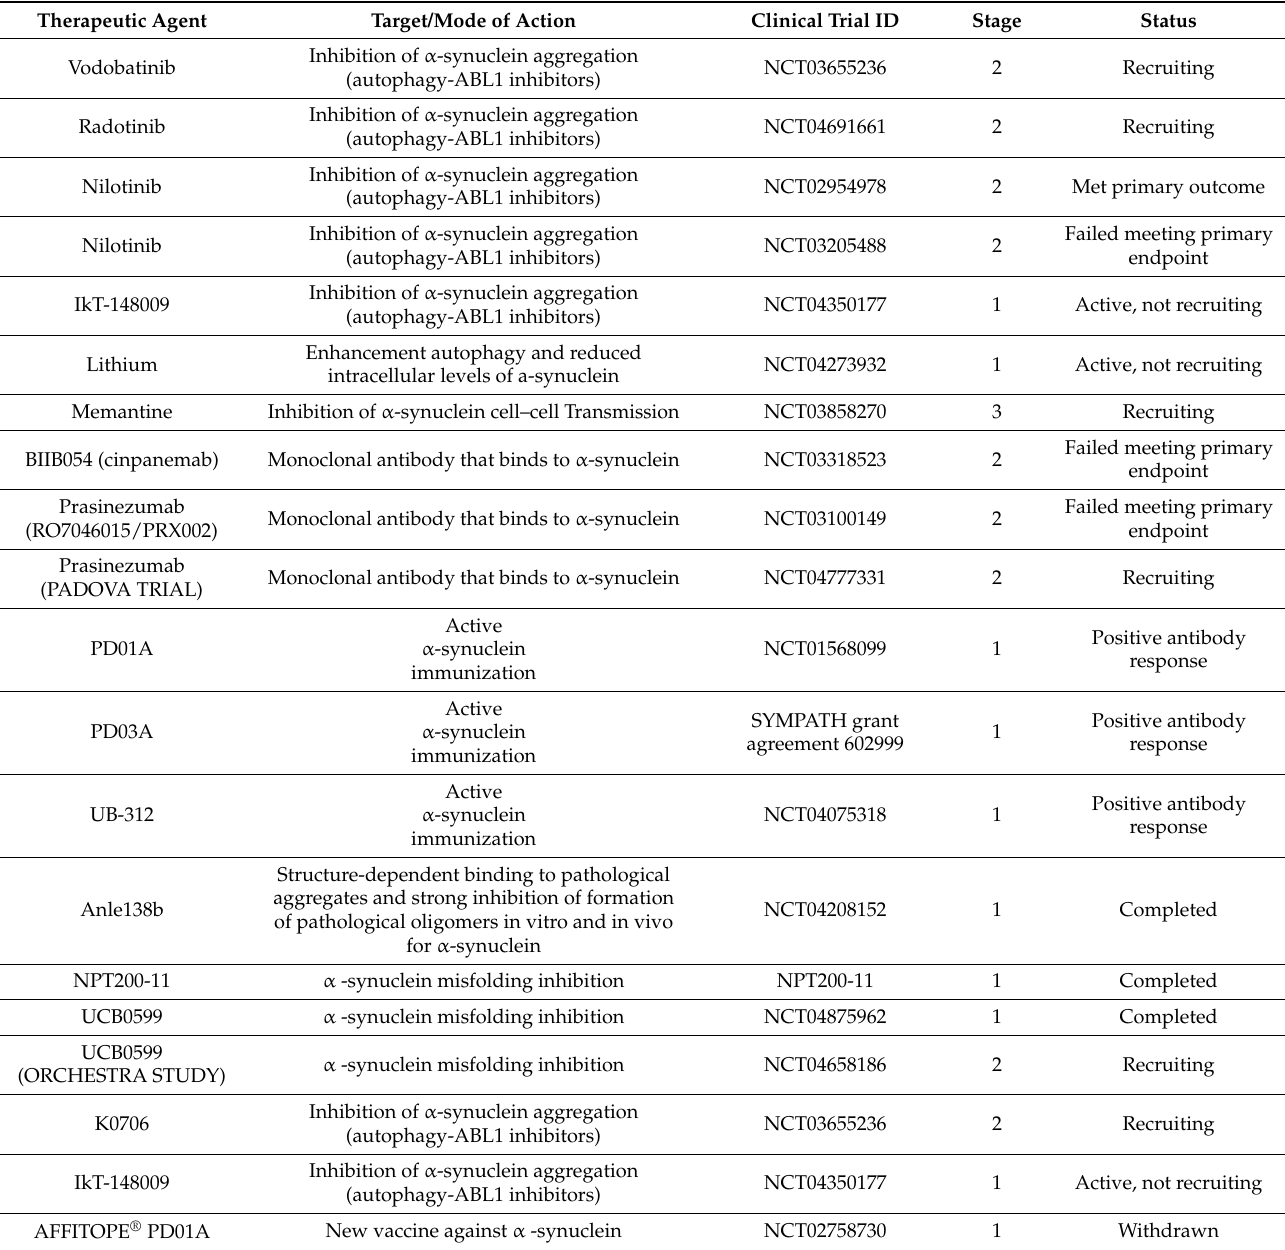
Table 4. Clinical trials of therapeutic interventions against